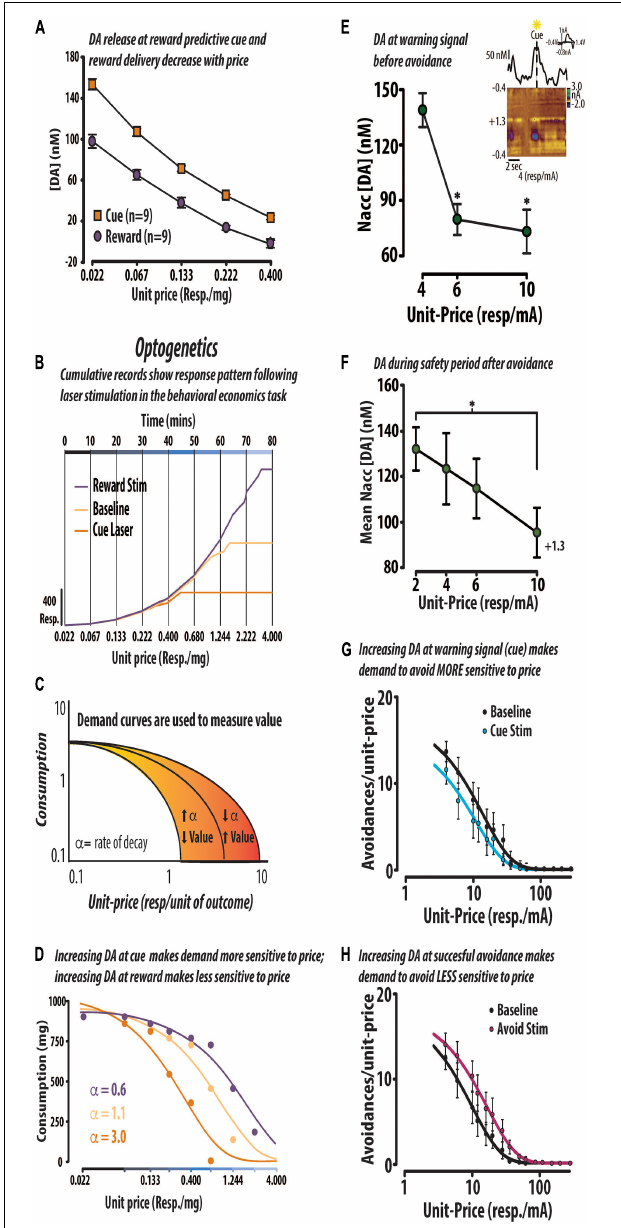
FIGURE 3 | DA value signals encode price and modify the maximal price rats will pay for positive or negative reinforcement. Positive reinforcement: DA (DA) concentration (mean ± SEM) evoked by a reward predictive cue and delivery of a 45 mg sugar pellet decreased across the first five prices in a within-session behavioral economics-based task. In this task, the unit-price (responses/mg sugar) increased across fixed epochs of time (A) . Optogenetic stimulation alters price sensitivity in a representative rat. Cumulative response records from one animal responding in the behavioral economic task under baseline conditions (light orange), and those in which DA release is amplified at cue presentation (dark orange) and at reward delivery (purple) (B) . Changes in value were assessed using demand curves which measure changes in consumption in response to changes in unit-price. We formally extracted a dependent measure of value (i.e., α ) which, represents the rate at which demand curve decay. Demand decays at a faster rate when the